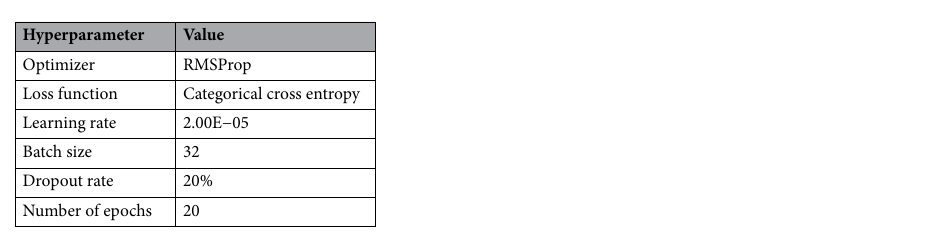
Figure 4. Architecture of the DenseNet model: base learner 3 (image has been made by R.K. using Google Slides).